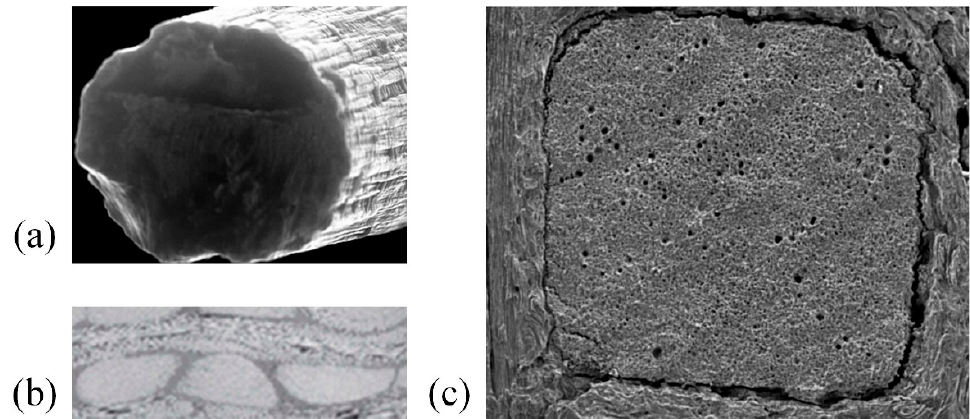
Figure 1. SEM images of ( a ) fiber (reprinted/adapted with permission from John Wiley and Sons, 2012 [42]); ( b ) 2D C/C composites (reprinted/adapted with permission from John Wiley and Sons, 2014 [44]); and ( c ) 3D C/C composites after ablation (reprinted/adapted with permission from Elsevier, 2017 [45]).